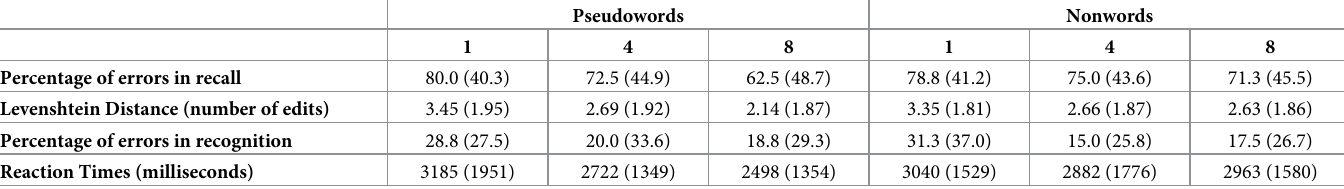
Table 3. Experiment 2. Descriptive statistics for each of the dependent variables in each of the conditions tested in the recall and recognition